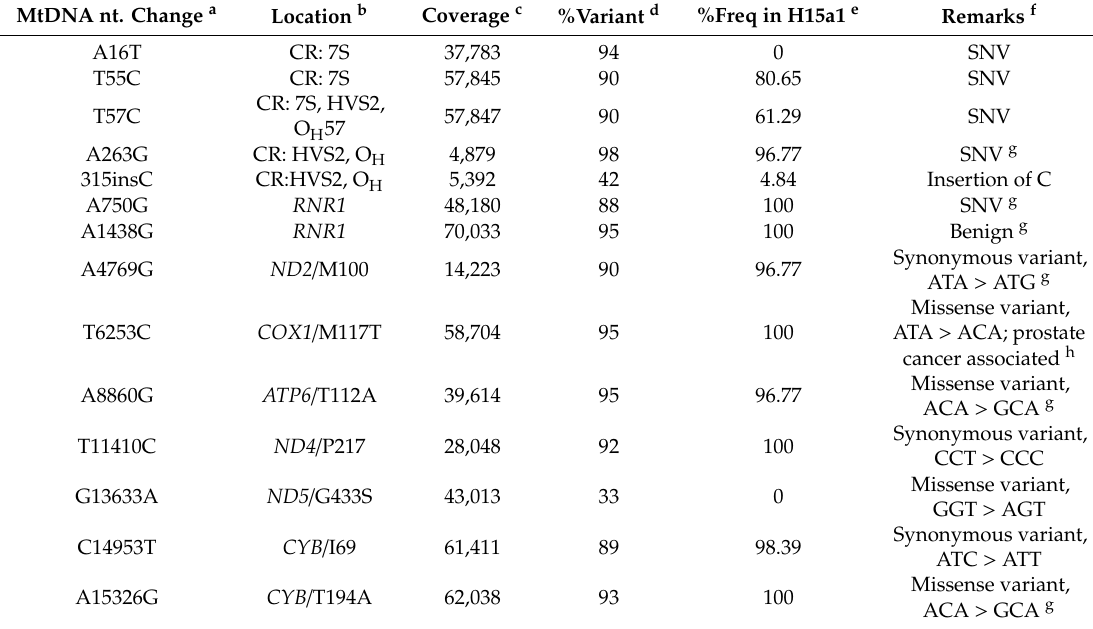
Table 1. Sequence changes and heteroplasmy identified in HepaRG mitochondrial DNA